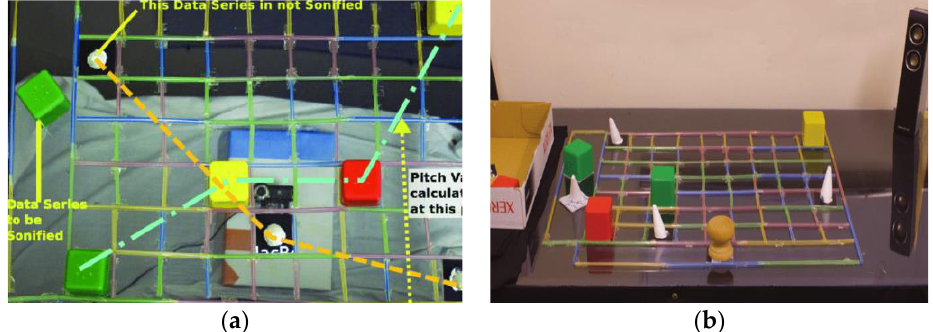
Figure 12. Illustration of the interaction with the Tangible Graph Builder ( a ), Tangible Graph Builder with tangible grid, and tangible objects ( b ) [28].